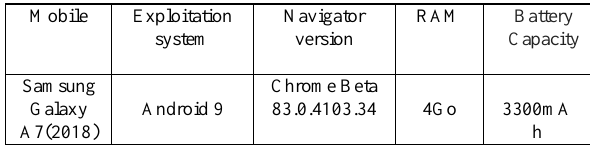
Table 1. Technical characteristic of the device